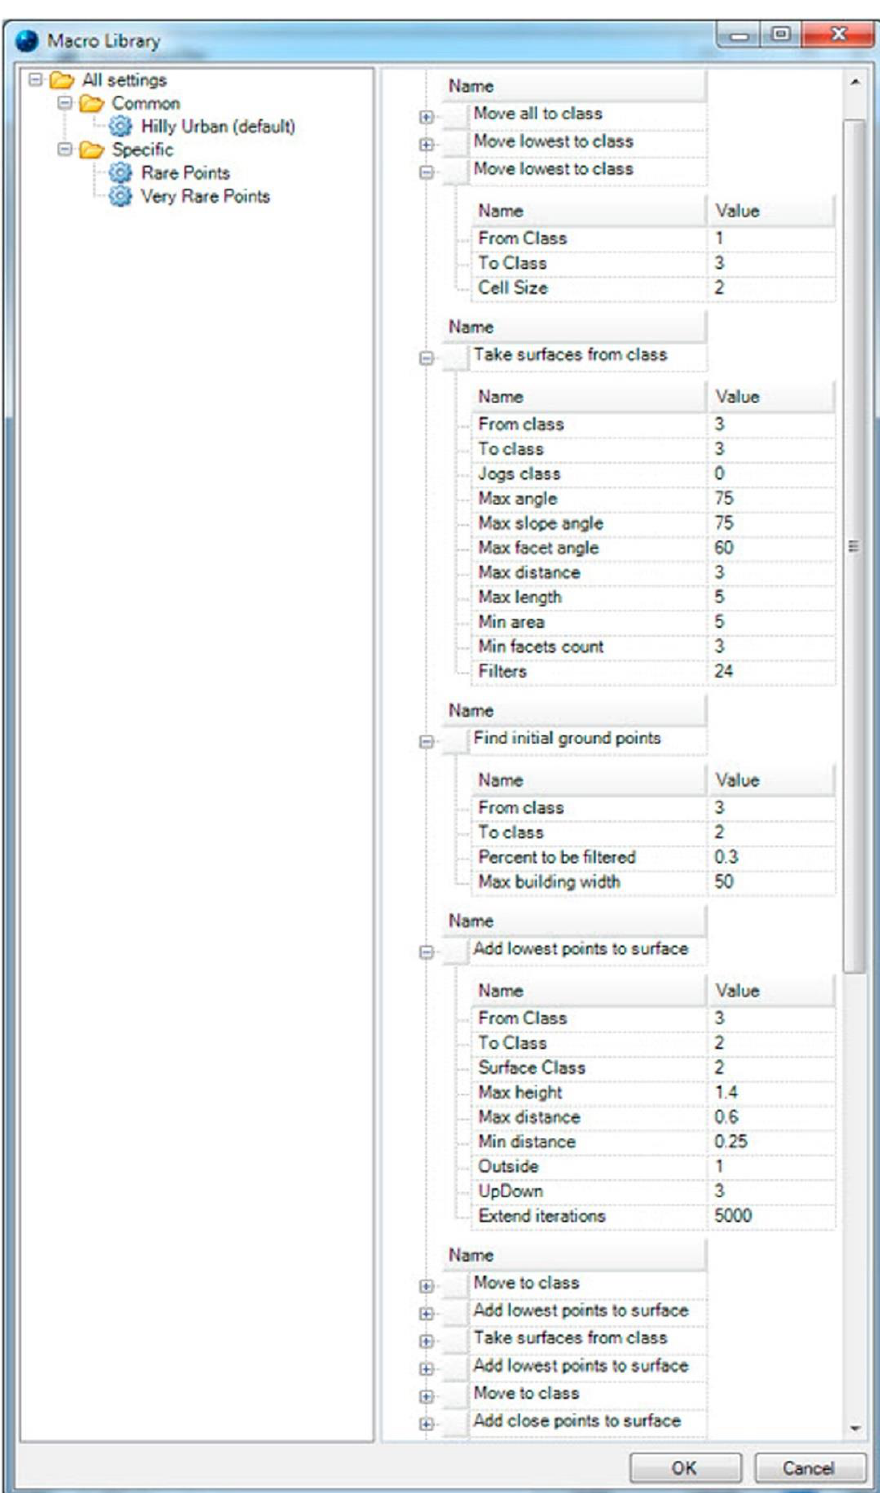
Figure 2. The input parameters for the second-sixth classifying blocks of the Ground branch of the two-branched DEM-G/AFE algorithmic solution within the HPM frameworks (Figure 1).